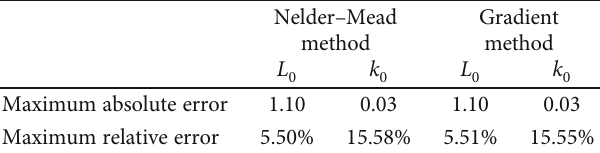
Table 3: Results of calculations with an error α = 10 % .